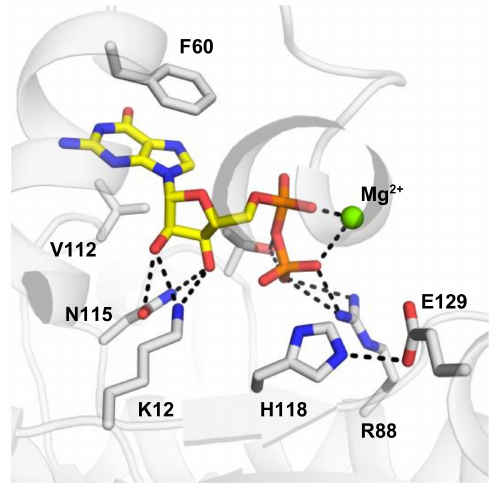
Figure 4. Active site of human NME2. Human NME2 is shown in light gray, with residues essential for substrate binding are highlighted in sticks. Complexed substrate Guanosine diphosphate (GDP) is shown in yellow with the β -phosphate lying close to the τ / N1 position of H118. Hydrogen bonds are shown in black dashed